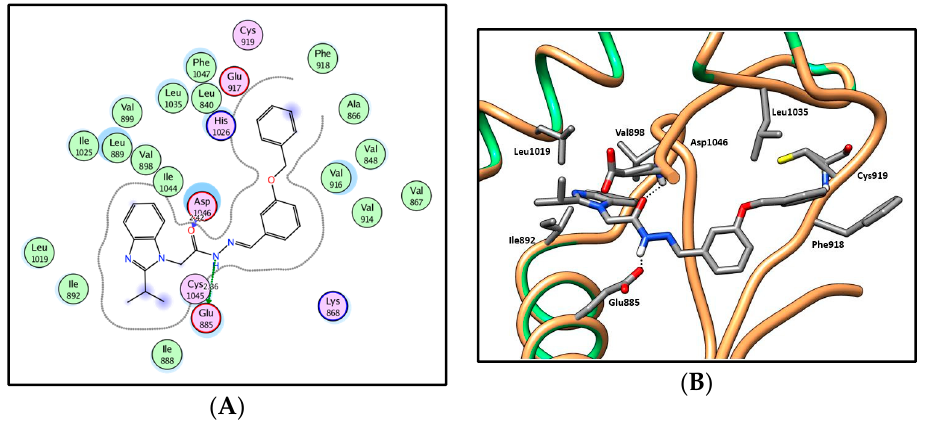
Figure 11. 2D diagram ( A ) and 3D representation ( B ) of compound 17a showing its interaction with the VEGFR-2 active site.